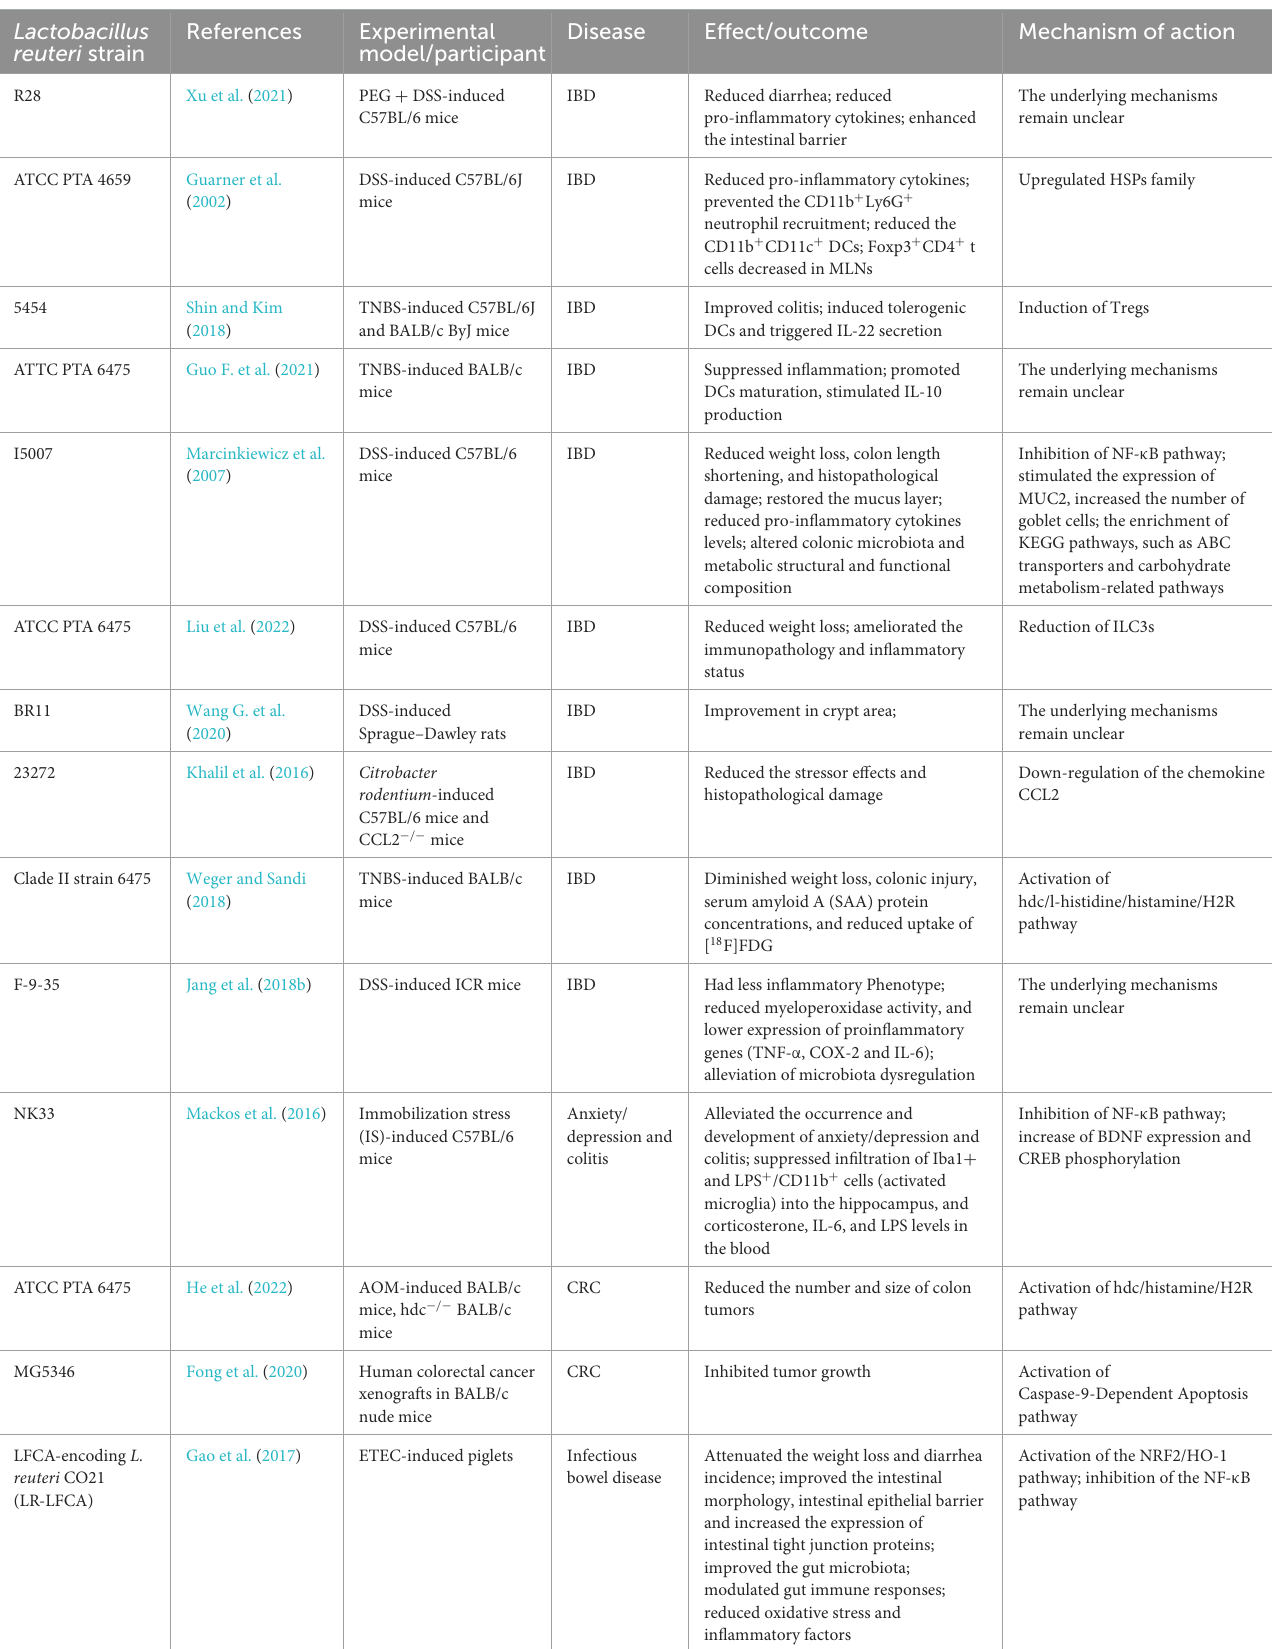
TABLE 2 Therapeutic efficacy and potential mechanisms of Lactobacillus reuteri strains in various intestinal diseases in animal models. Lactobacillus reuteri